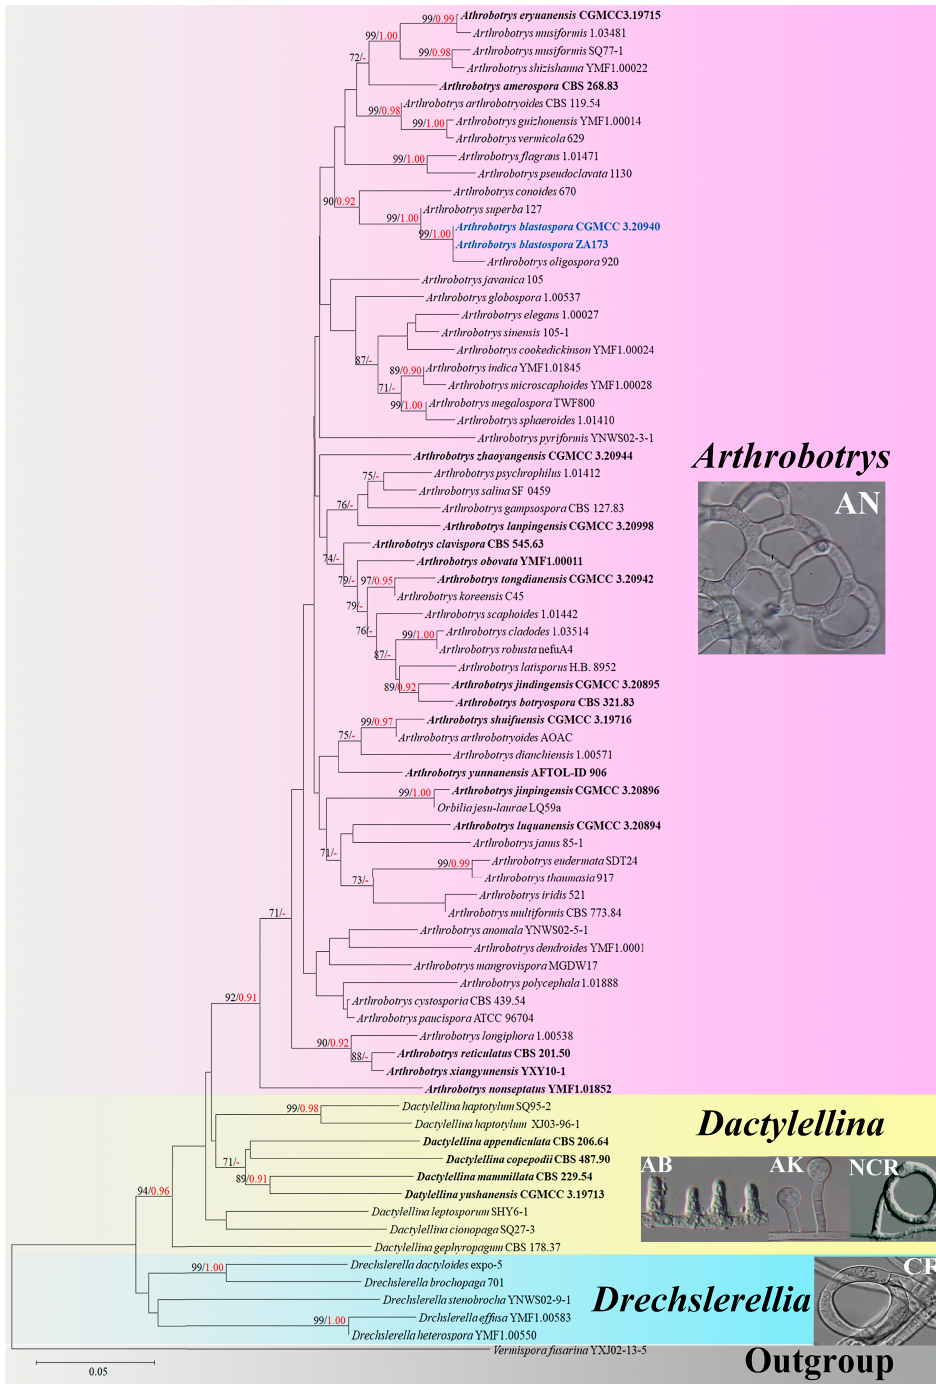
Figure 1. Maximum likelihood tree based on combined ITS, TEF, and RPB2 sequence data from 72 Or- biliaceae (Orbiliomycetes) carnivorous species. Bootstrap support values for maximum likelihoods (black) equal to or greater than 70% and Bayesian posterior probability values (red) equal to or greater than 0.90 are indicated above the nodes. The new isolates are in blue and the type strains are in bold. The genus name and trapping structure corresponding to each clade are indicated on the right. AN, adhesive networks; AB, adhesive branches; AK, adhesive knobs; NCR, non-constricting rings; CR, constricting